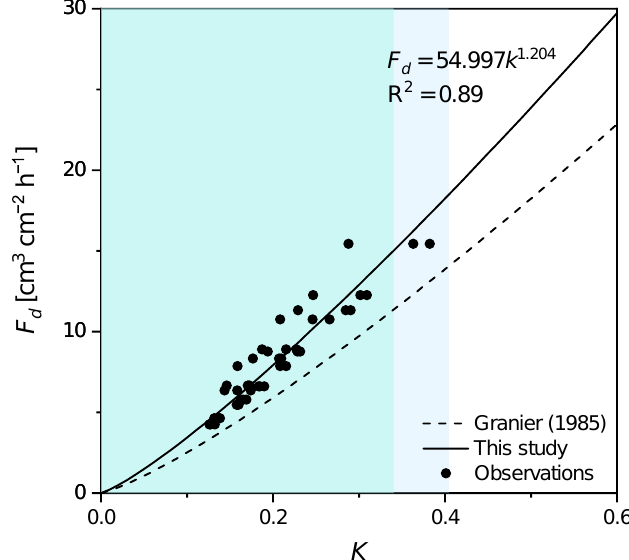
Figure 4. Sap flux density ( F d ) vs sap flux index ( K ) of balsam fir stem segments ( n = 3; each having 3 sap flow sensors × 5 pressure heads) obtained for this study, compared to the commonly used Granier’s [33] calibration curve. The green and blue shaded area is the range of K values observed in Juvenile and Sapling sites,